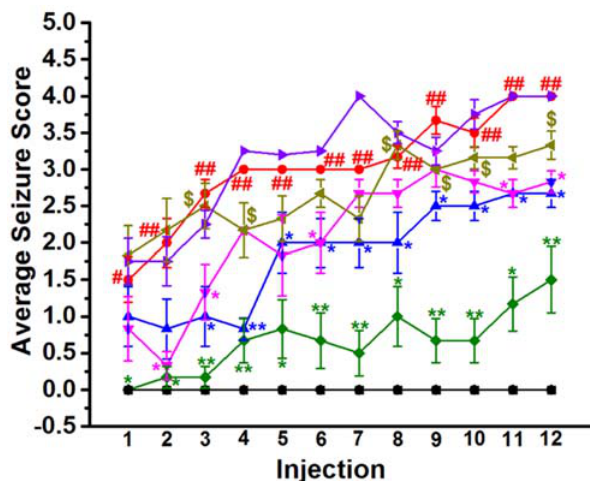
Figure 1. H3R antagonist E177 reduced the average seizure score of PTZ ‐ kindled rats. Effects of PTZ (40 mg/kg), H3R antagonist E177 (5 and 10 mg/kg; i.p.) and VPA (300 mg/kg, i.p.) on average seizure score were assessed. Black lines represent SAL ‐ treated group and the RAM ‐ treated control group. Green line represents VPA (300 mg/kg) ‐ treated group. Blue line represents H3R antagonist E177 (5 mg/kg) ‐ treated group. Pink line represents H3R antagonist E177 (10 mg/kg) ‐ treated group. Dark ‐ yellow line represents RAM (10 mg/kg) + E177 (5 mg/kg) ‐ treated group. Red represents PTZ (40 mg/kg) ‐ treated group. Violet line represents RAM ‐ treated PTZ ‐ kindled group. Effects shown are expressed as average of seizure score for 30 min observation time for each PTZ injection. H3R antagonist E177 (5 and 10 mg/kg; i.p.) and VPA (300 mg/kg, i.p.) were administered 30 ‐ 45 min prior each PTZ ‐ injection. Effects of systemic co ‐ injection with RAM (10 mg/kg, i.p.) on H3R antagonist E177 (5 mg/kg) ‐ provided anticonvulsant effect was evaluated. Values are expressed as the mean ± SEM ( n = 12). * P < 0.05 vs PTZ ‐ kindled group. ** P < 0.001 vs PTZ ‐ kindled group. # P < 0.05 vs saline ‐ treated